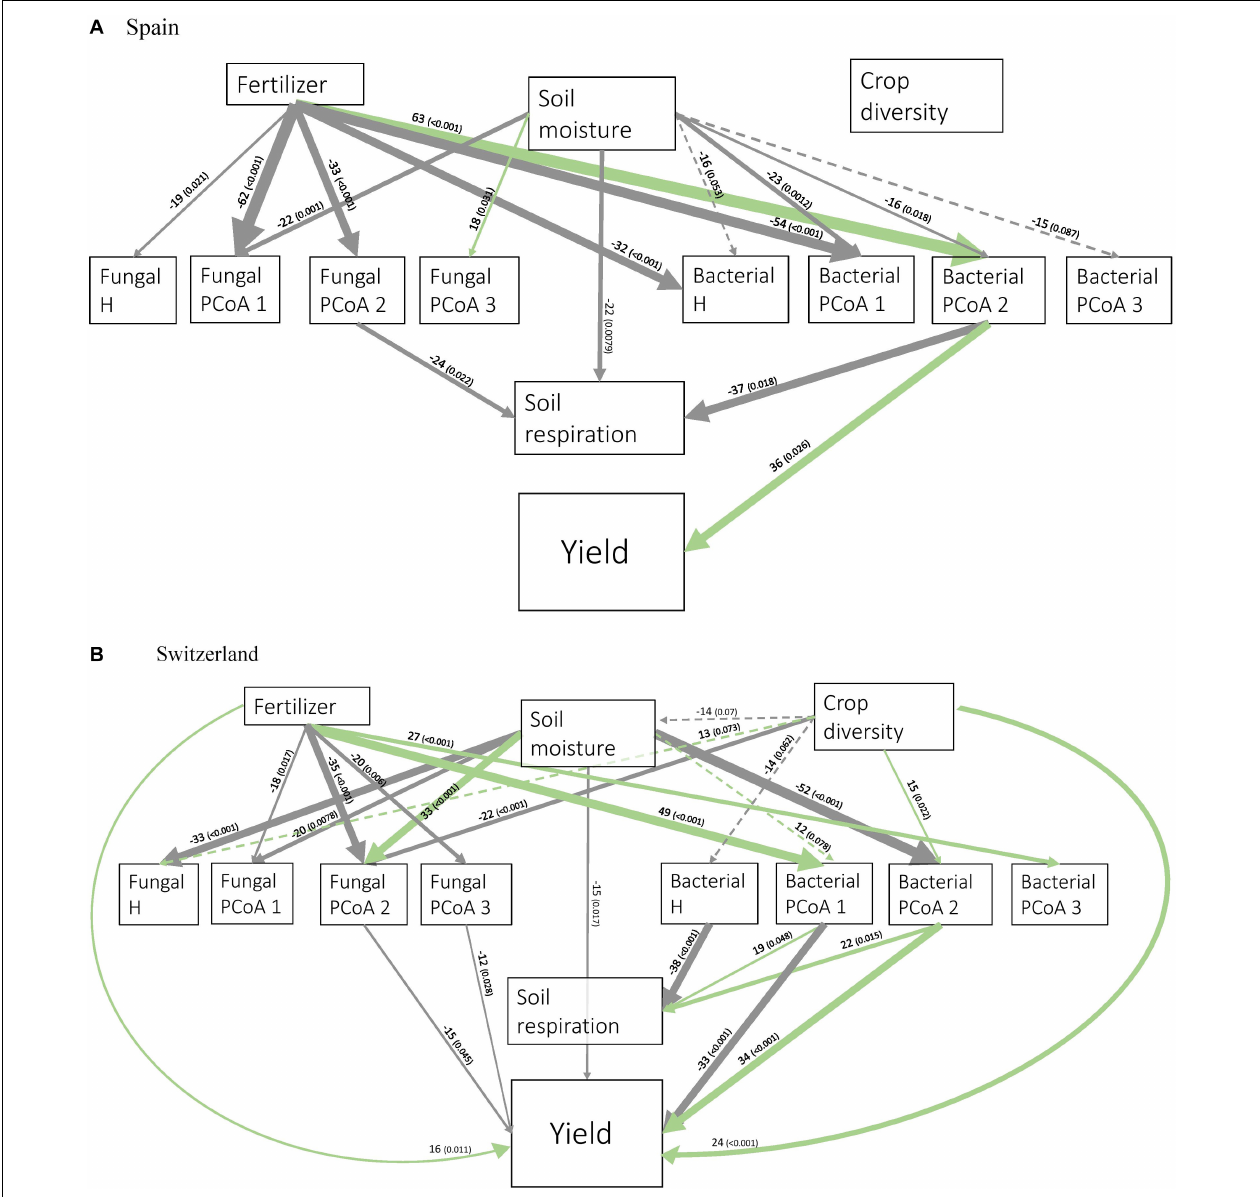
FIGURE 3 | Structural Equation Modeling showing the relationships between crop diversity, fertilizer, soil moisture, soil activity, and bacterial and fungal diversity measures in Spain (A) and Switzerland (B) . H: Shannon’s diversity. Only significant (solid line) and marginally significant (dashed line) relationships are shown. Width of arrows are proportional to the strength of the standardized path coefficients indicated by the numbers above the arrows. The numbers in brackets indicate associated p -values. Colors of the arrows show positive (green) and negative (gray) effects. Residual correlations are not